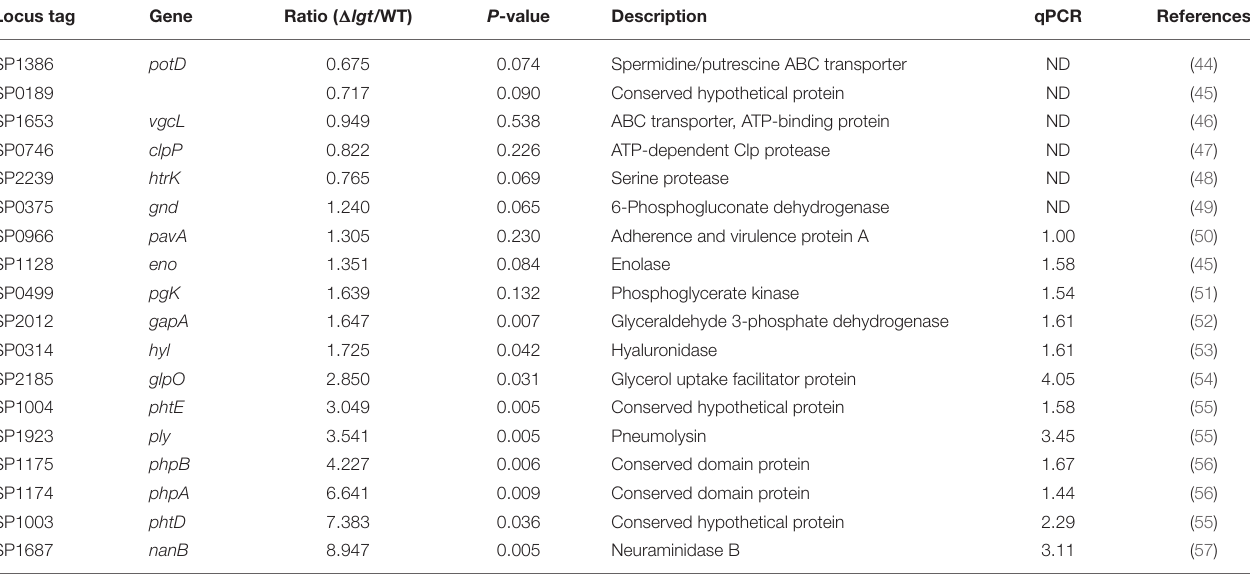
TABLE 1 | mRNA expression of candidate vaccine genes in wild-type TIGR4 and TIGR4 1 lgt pneumococci. Locus tag